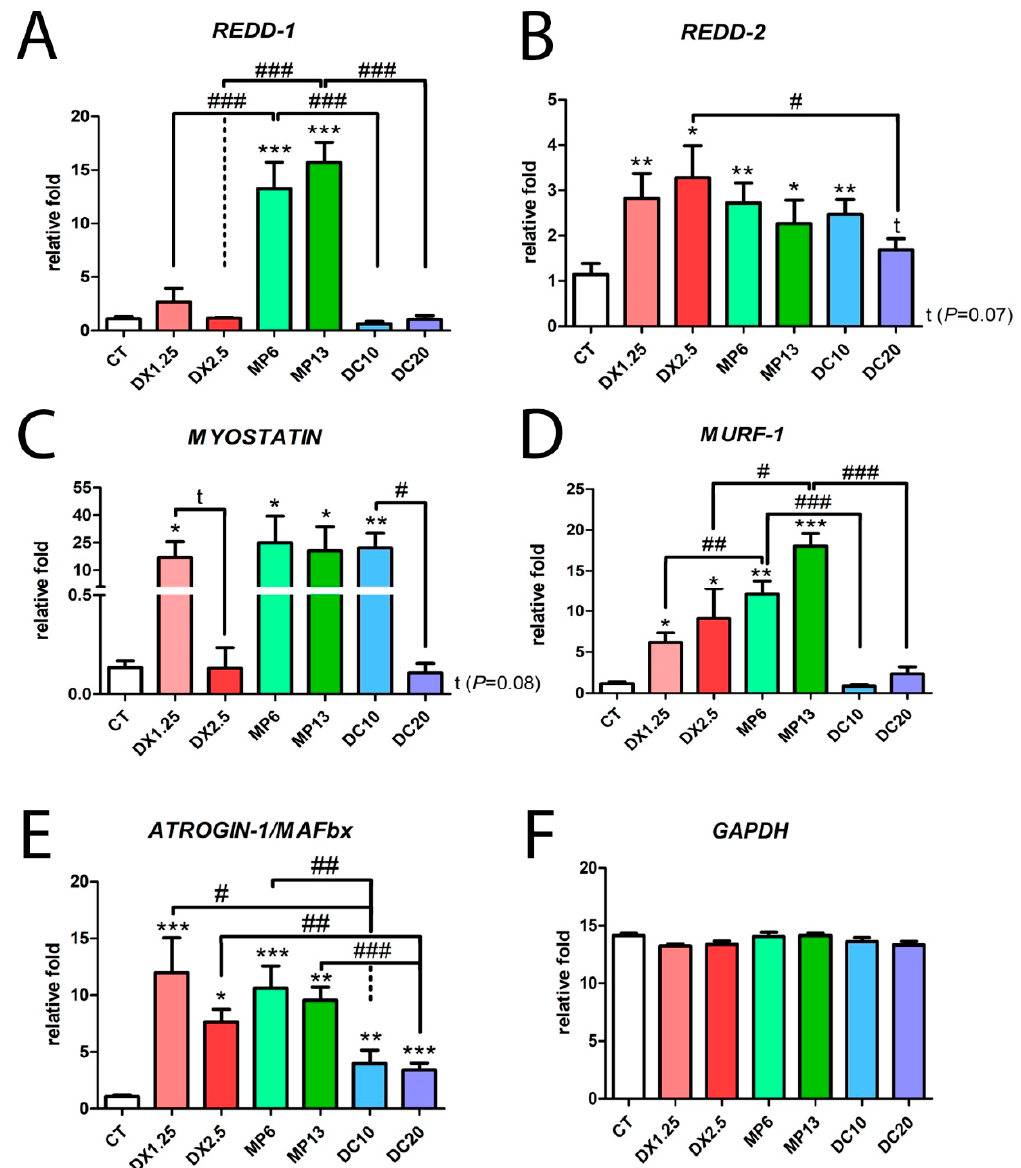
Figure 4. mRNA expression by RT-PCR of MURF-1 , Atrogin - 1 / MAFbx , REDD-1 , REDD-2 and MYOSTATIN after administration of di ff erent glucocorticoids. Atrogenes expression ( A – E ), Myostatin expression ( C ), housekeeping gene expression GAPDH ( F ). (*) represents the statistical di ff erence in comparison to the CT, and (#) represents statistical di ff erence between groups. Legend: * or # = P < 0.05; ** or ## = P < 0.01 and *** or ### = P < 0.001. ( n per group: CT = 10, DX1.25 = 9, DX2.5 = 8, DC10 = 10, DC20 = 10, MP13 = 8, MP6 = 8).